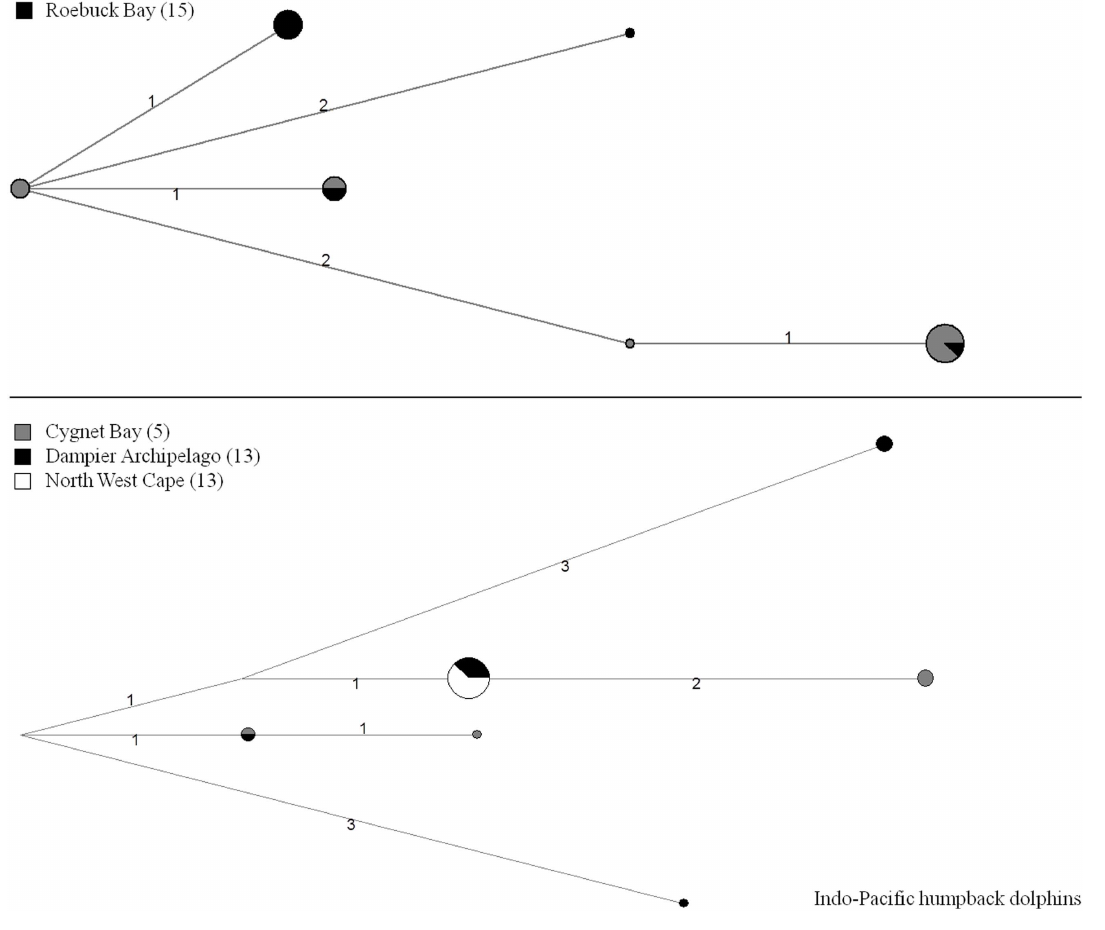
Figure 2. mtDNA networks for snubfin and humpback dolphins. Sample sizes are shown in parentheses. Branch numbers indicate the number of nucleotide differences between mtDNA haplotypes.